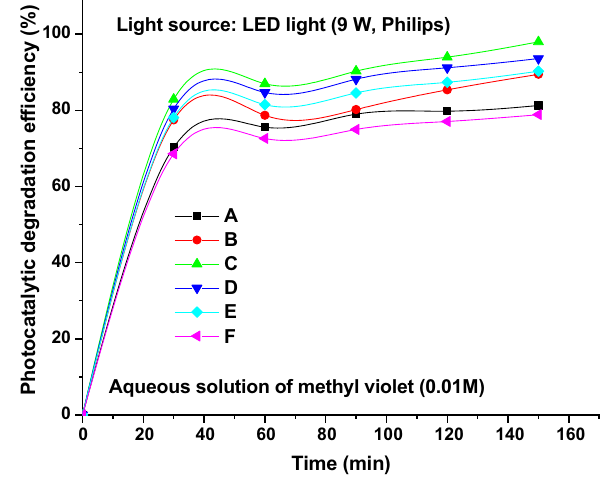
Fig. 10 Effect of irradiation on photocatalytic degradation efficiency